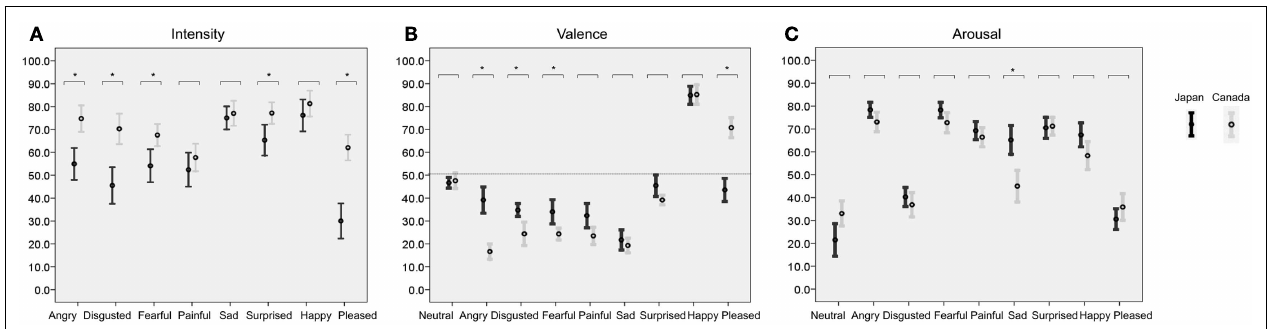
FIGURE 1 | Shows the distribution of ratings (error bar: mean ± SD) for each emotional sound judged by 30 Japanese and 30 Canadian participants for (A) Intensity, (B)Valence, and (C)Arousal. Each horizontal axis represents each rating score (0–100). Each vertical axis shows categories